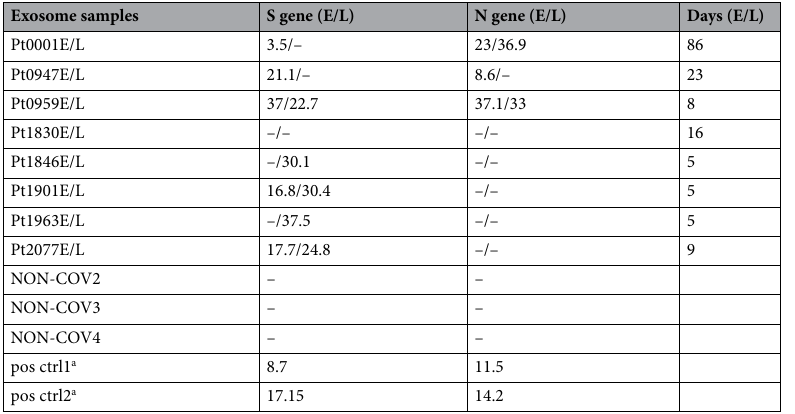
Table 1. Viral RNA in COVID-19 plasms exosomes. Pt0001E/L–Pt1963E/L, COVID-19 patients earlier (E) and later (L) in their hospitalization; (E/L), viral RNA RT-qPCR in plasma exosomes from COVID-19 patients earlier (E) and later (L) in their hospitalization, respectively. Cycles of qPCR presented; NON-COV, non- COVID samples; a positive control RNA (pos ctrl) from the manufacture; –, not detected by RT-qPCR.